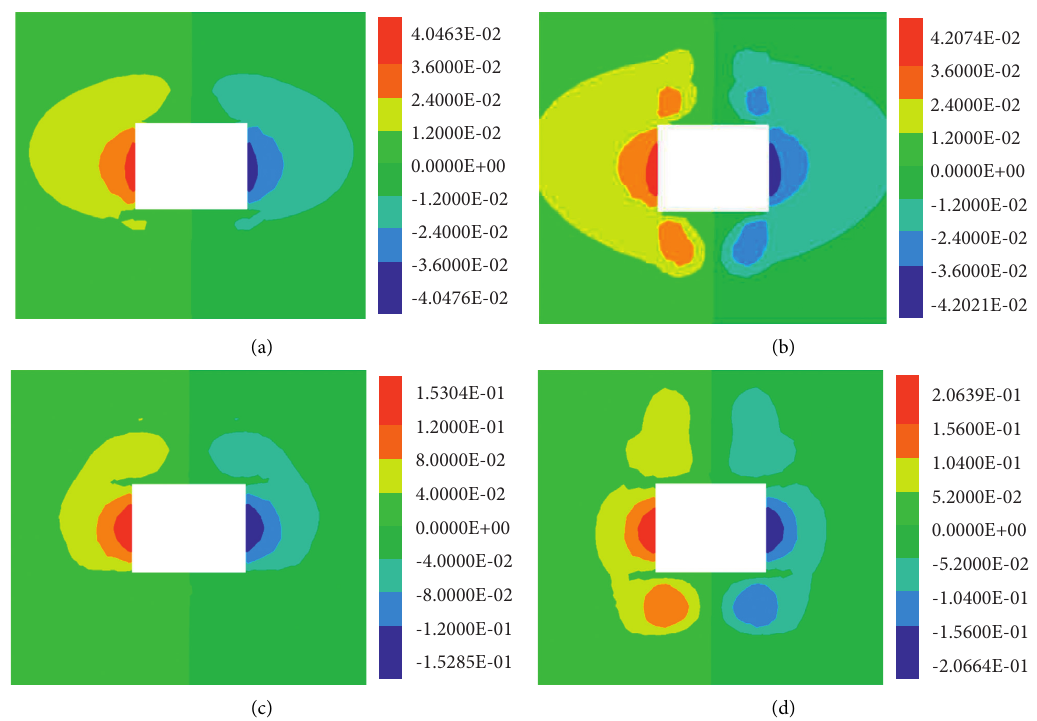
Figure 8: Horizontal displacement distributions of surrounding rock of weakly cemented soft rock in the roadway under different simulation schemes. (a) Without softening and expansion. (b) With expansion. (c) With softening. (d) With softening and expansion.